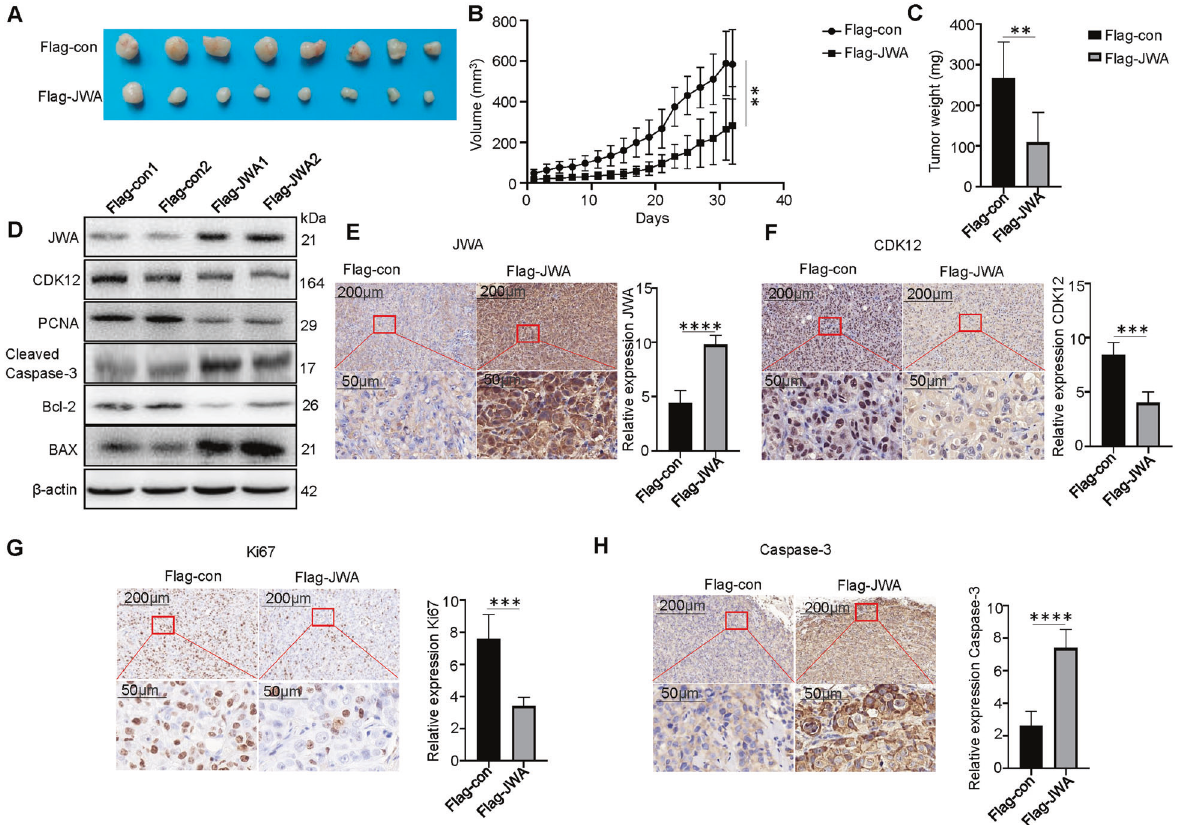
Fig. 7 JWA suppresses tumor growth of trastuzumab-resistant breast cancer by downregulating CDK12 In vivo. A The xenograft tumors formed by JWA-overexpressed and control vector in JIMT1 cells. B , C The size and weight of the xenograft tumors formed by JWA- overexpressed and control cells. D Protein levels of JWA, CDK12, BAX, Cleaved Caspase-3, Bcl-2, PCNA in tumors formed by JWA-overexpressed and control cells. β -actin served as the internal control. E − H Images for JWA, CDK12, Ki67, and Caspase-3 staining are shown for the xenografts. The IHC of animal models showed that JWA increased after overexpression of JWA, CDK12 and Ki67 expression decreased, and Caspase-3 expression increased. ** P < 0.01, *** P < 0.001, **** P <